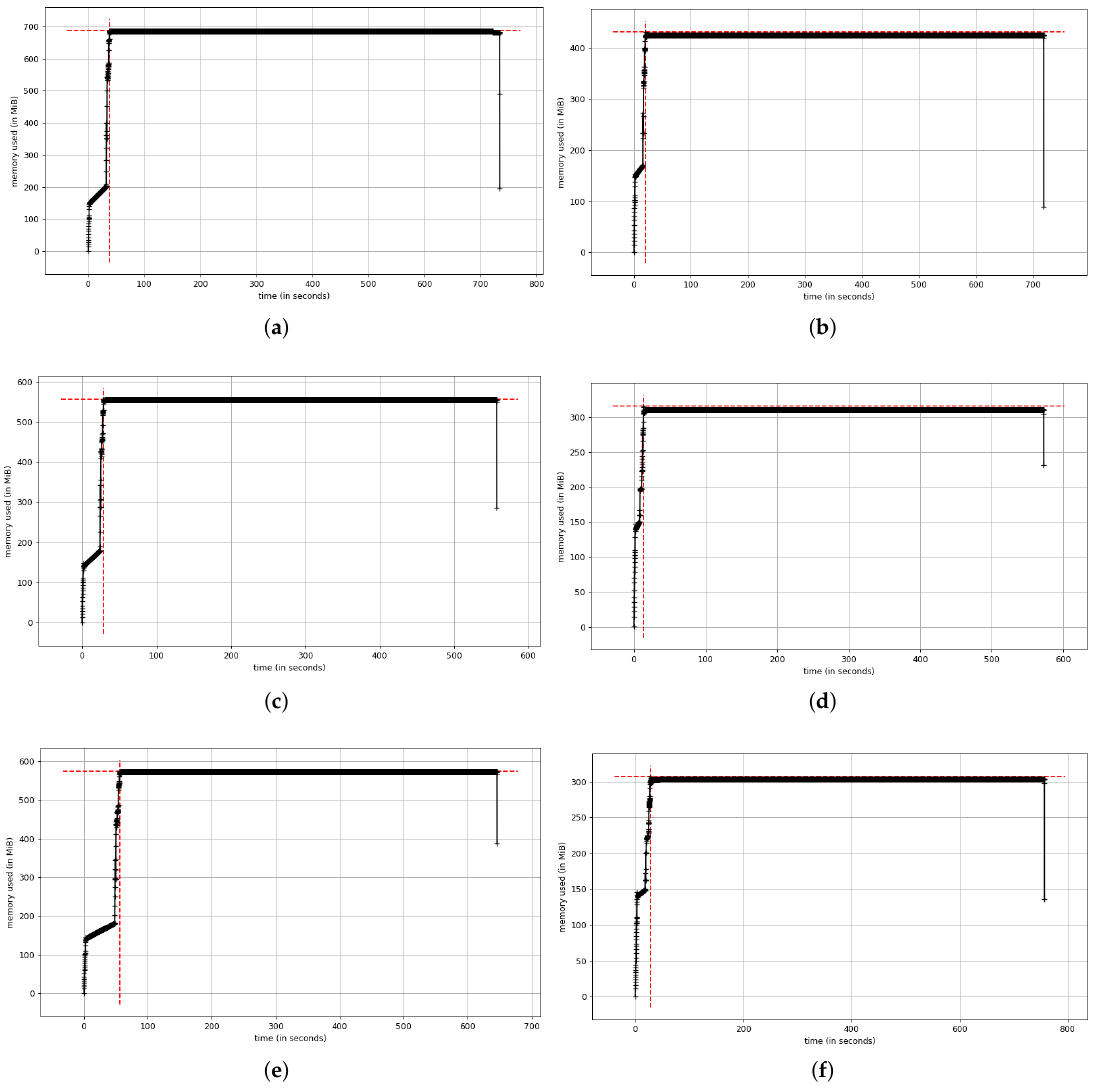
Figure 18. Memory profile results of LSTM model on complete feature data and selected feature subset data respectively. ( a ) & ( b ) Tuesday data; ( c ) & ( d ) Wednesday data; ( e ) & ( f ) Thursday data.